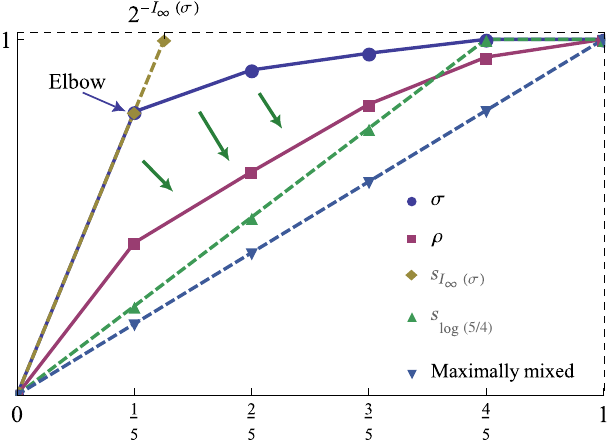
FIG. 1. Lorenz curves. (a) The Lorenz curve for ρ is defined by P k n η plotting the points: fð k=n; i Þg i ¼ 1 k ¼ 1 . (b) The transition from σ to ρ is possible under NO, as the curve for σ is never below that of ρ . (c) The Lorenz curve for a maximally mixed state is given by the dashed line from (0,0) to (1,1). All other states majorize it. (d) s is an example of a sharp state. (e) s I is the least log ð 5 = 4 Þ ∞ ð σ Þ sharp state that majorizes σ